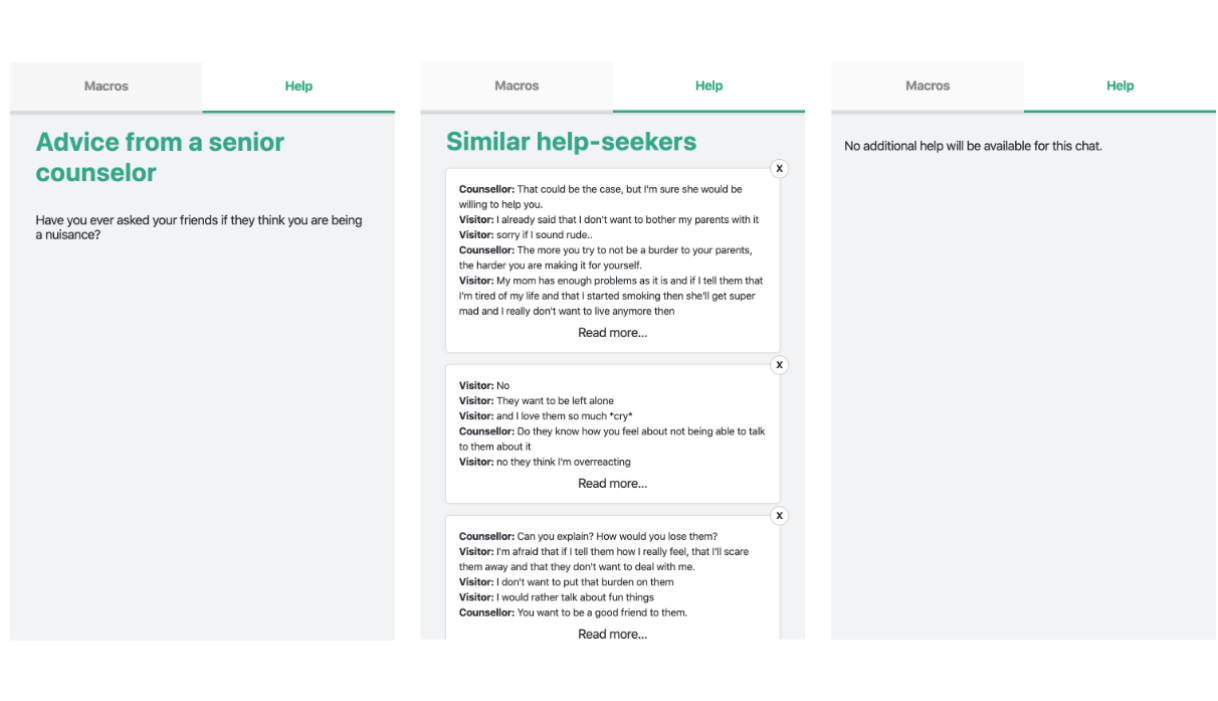
Figure 3. Conditions of the experiment: senior counselor written advice (left); support system (center); no additional help (right). Content translated from